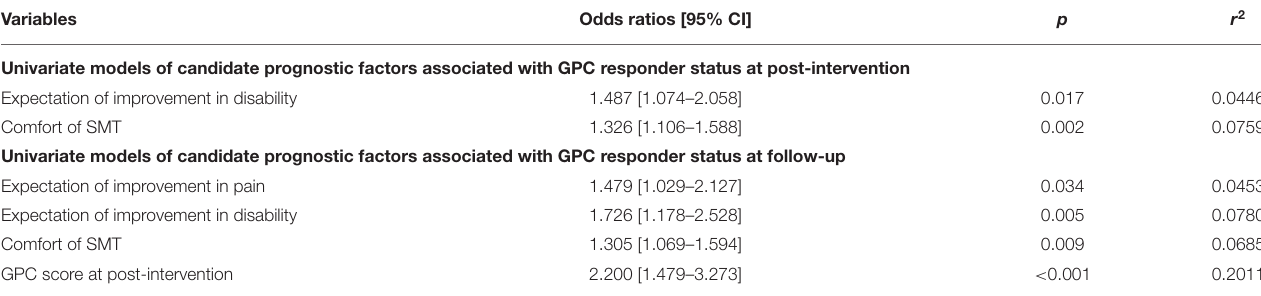
TABLE 6 | Univariate models of candidate prognostic factors associated with GPC responder status at post-intervention and follow-up (Odds Ratios, confidence intervals and p -values). Variables Odds ratios [95% CI] p r